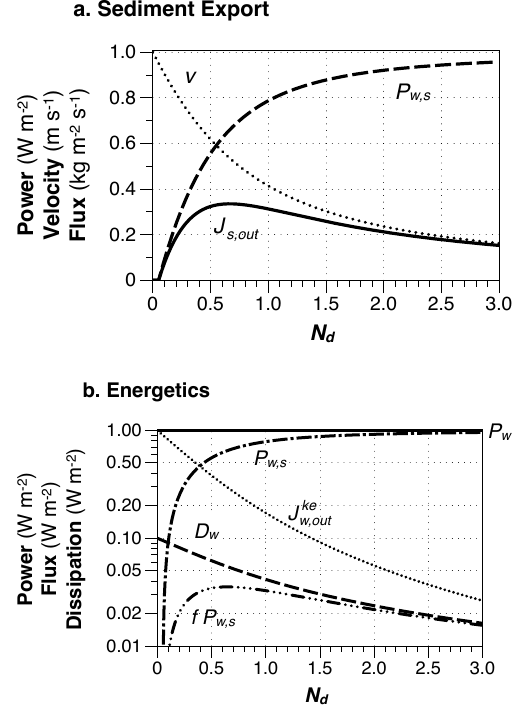
Fig. 4. Demonstration of a maximum rate of sediment export result- ing from the tradeoff of increased drag resulting in greater work in detaching sediments, P w,s , but lower flow velocity, v . (a) Water flow velocity v , free energy transfer, P w,s , and rate of sediment export, J s,out , as a function of the dimensionless number, N d , that charac- terizes the strength of the drag force, F w,d , in relation to the acceler- ating force, F w,acc , associated with the slope. (b) Sensitivity of total power, P w , frictional dissipation, D w , in water flow, kinetic energy export, J ke w,out , of water flow, and the free energy transfer, P w,s , from water flow to sediment transport, and the fraction, f P w,s , that re- sults in sediment export.